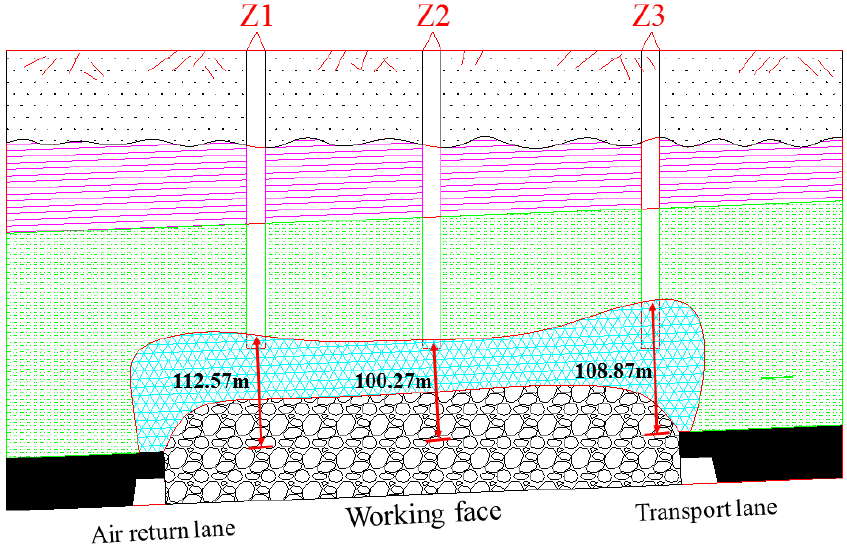
Figure 10. Development pattern of water flowing fractured zone after caving at the 7802 face.